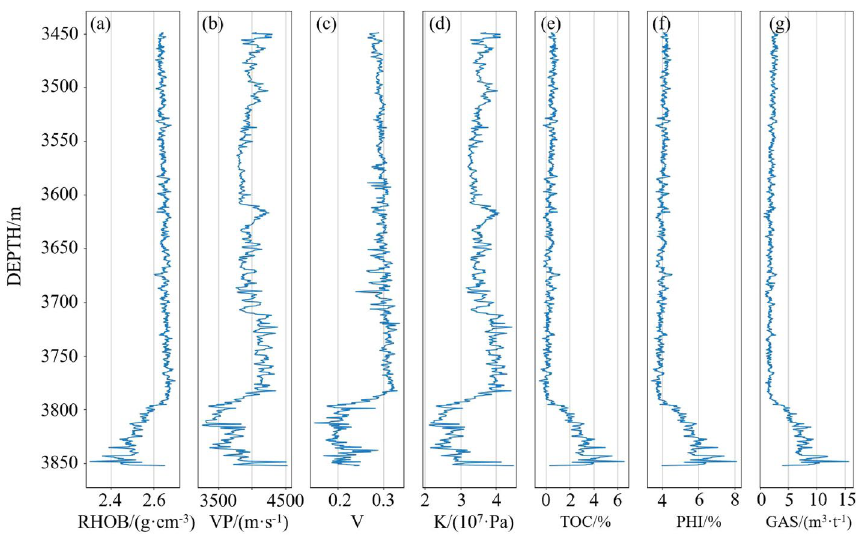
Figure 7. Well logging curves of WY23. ( a ) density, ( b ) longitudinal wave velocity, ( c ) Poisson’s ratio, ( d ) bulk modulus, ( e ) total organic carbon content, ( f ) porosity and ( g ) gas